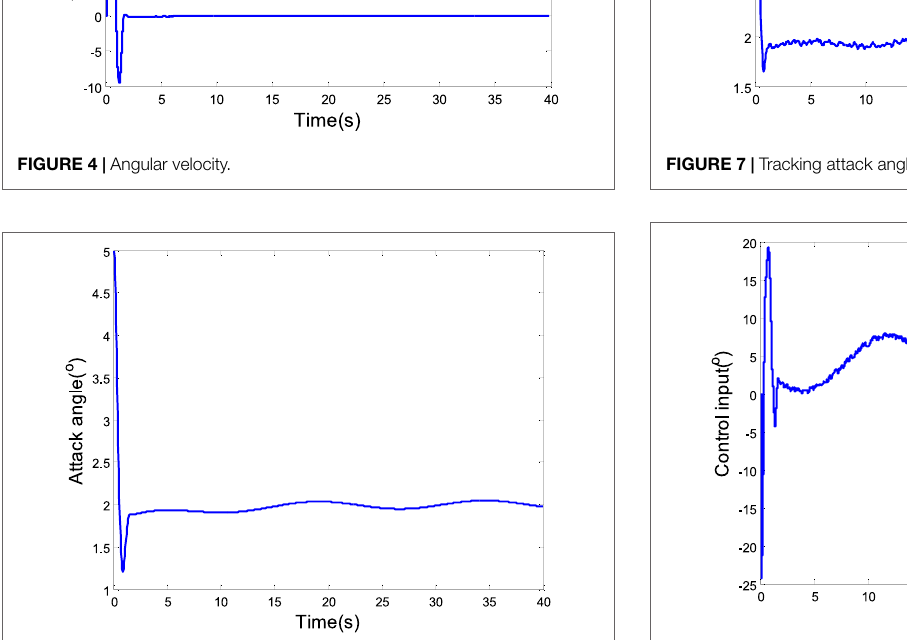
FIGURE 8 | Control